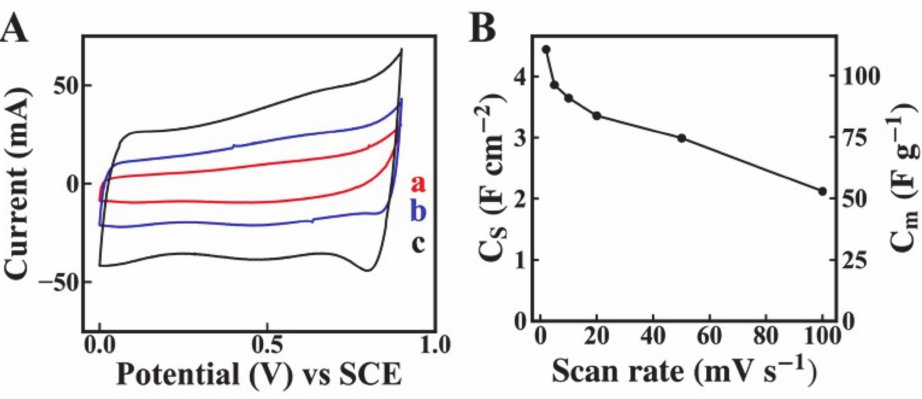
Figure 5. ( A ) CVs at scan rates of (a) 2, (b) 5, (c) 10 mV s − 1 , and ( B ) C S and C m versus scan rate for Mn 3 O 4 -MWCNT